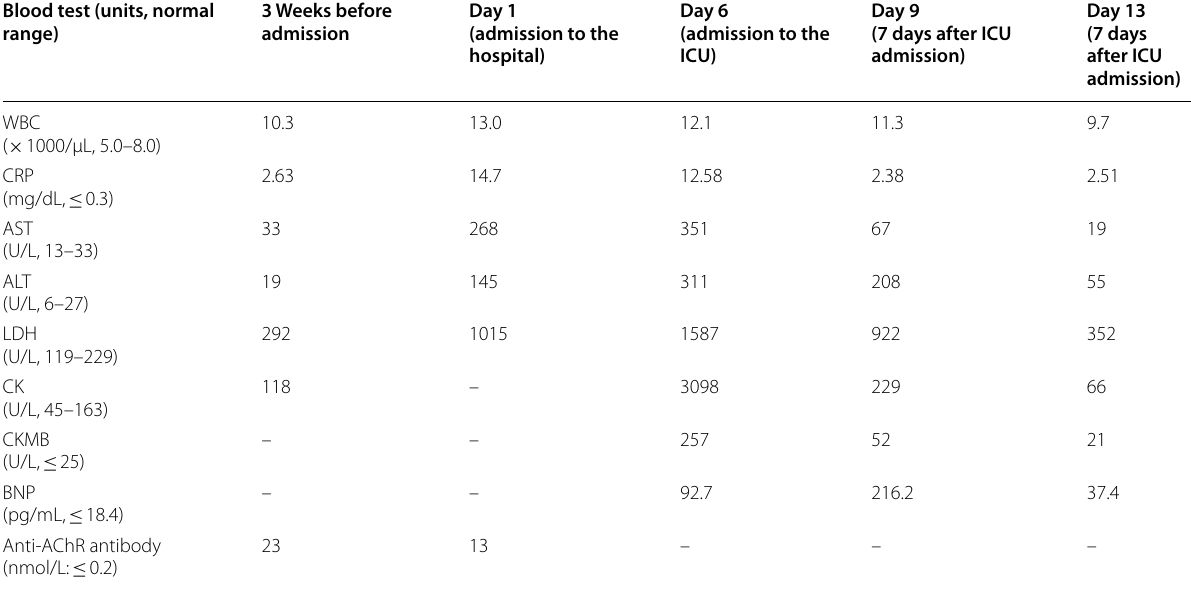
ICU intensive-care unit, WBC white blood cell counts, CRP C-reactive protein, AST aspartate aminotransferase, ALT alanine aminotransferase, LDH lactate dehydrogenase, CK creatine kinase, CKMB creatine kinase–myoglobin binding, BNP brain natriuretic peptide, anti-AChR antibody anti-acetylcholine receptor antibody